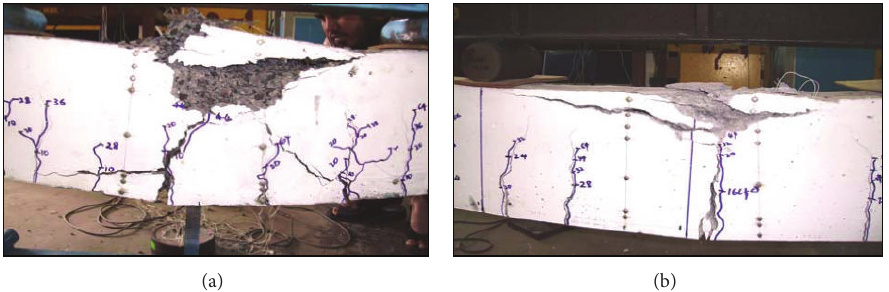
Figure 2: Failure of reinforced (a) OPS concrete and (b) NWC beam